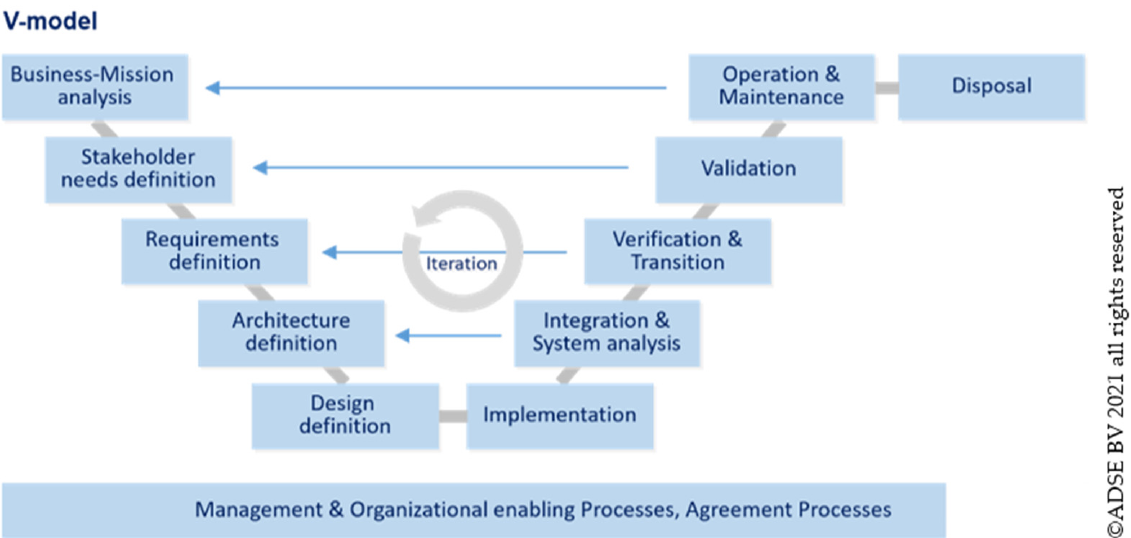
Figure 1. V-model of systems engineering.